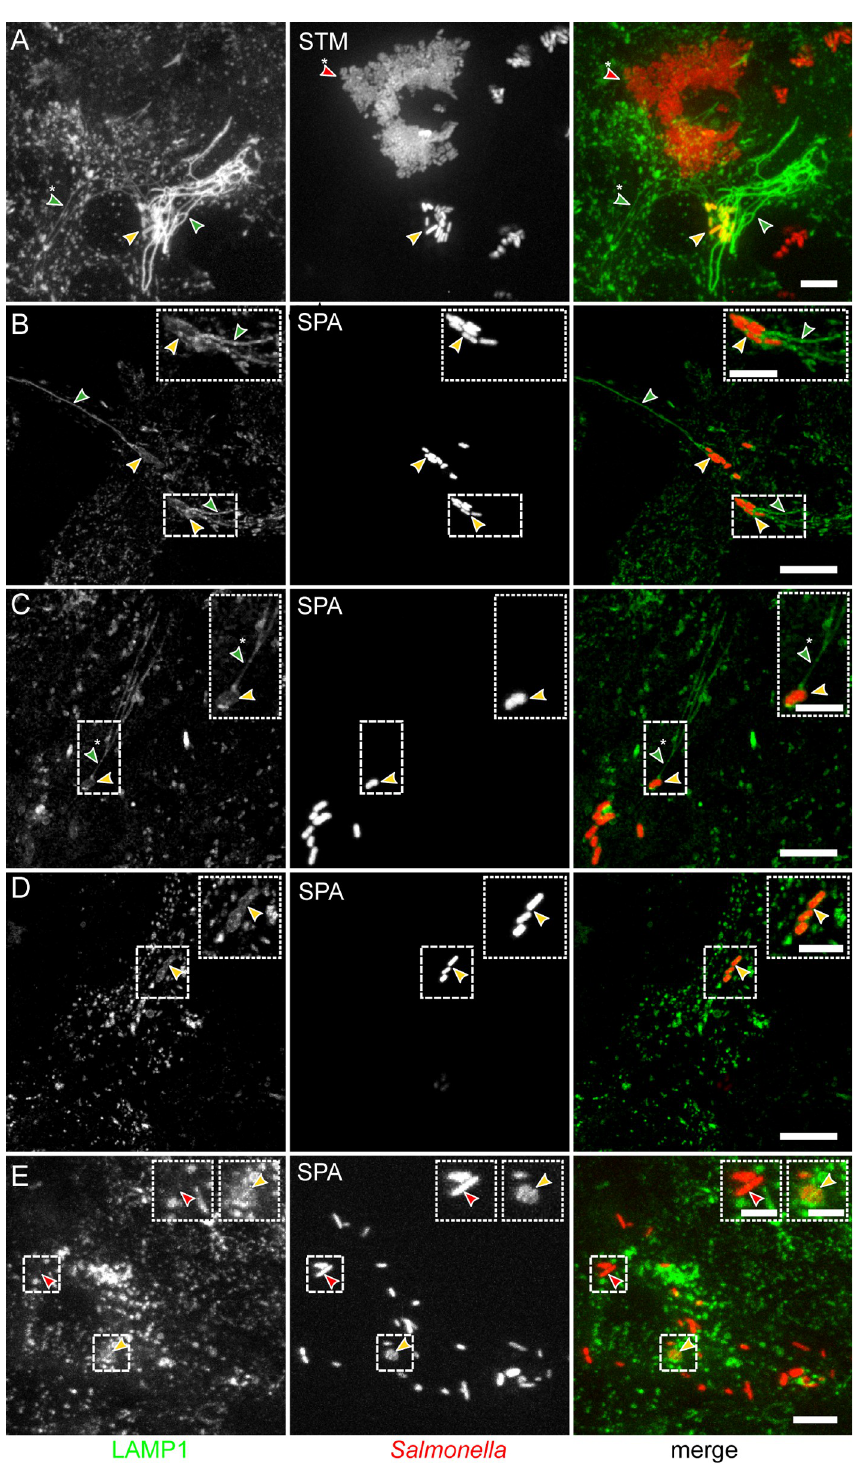
Fig 8. Distinct phenotypes of intracellular SPA. HeLa cells stably transfected for expression of LAMP1-GFP (green) were infected with STM WT ( A , MOI 25) or SPA WT ( B-E , MOI 75), each harboring pFPV-mCherry for constitutive expression of mCherry (red). Live-cell imaging was performed at 8 h p.i. Images are shown as maximum intensity projection. Arrowheads indicate subpopulations with distinct phenotypes in infected cells: SIF (green), thin SIF (green with asterisk), Salmonella residing in SCV (yellow), cytosolic Salmonella (red), hyper-replicating cytosolic Salmonella (red with asterisk). Scale bars: 10 μ m (overview), 5 μ m (inset). https://doi.org/10.1371/journal.ppat.1010425.g008 PLOS Pathogens| https://doi.org/10.1371/journal.ppat.1010425 April 5,